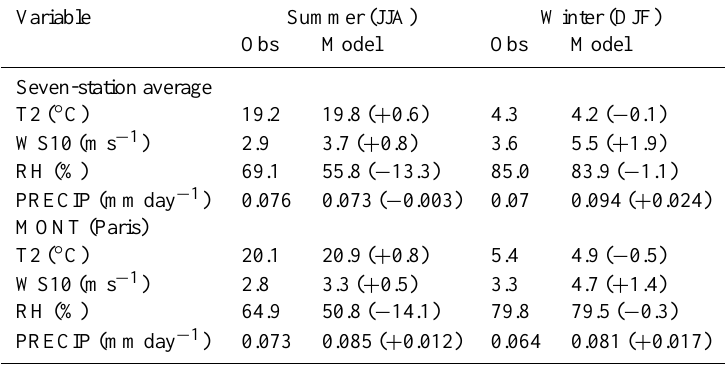
Table 3. Observed and modeled meteorological variables over the Ile-de-France region. Modeled data stem from the WRF simulation at 10km resolution. Absolute model bias is given in parenthesis. MONT refers to the Montsouris